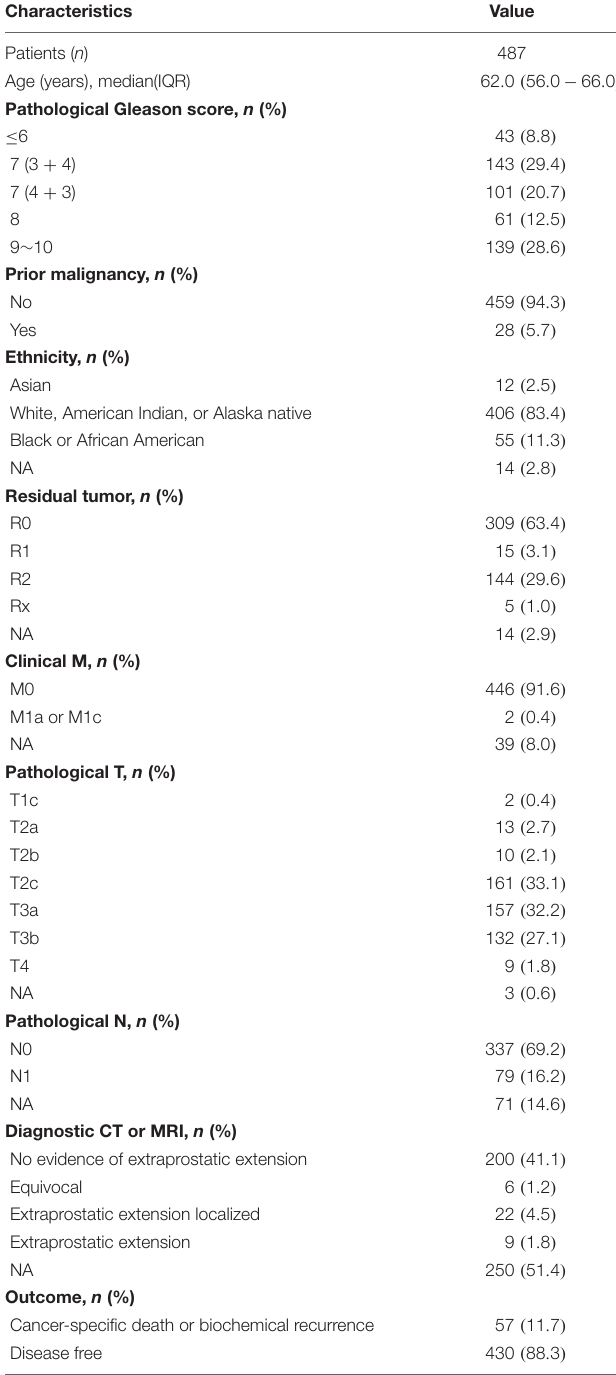
TABLE 1 | The clinicopathologic variables of patients with PCa included in the study.